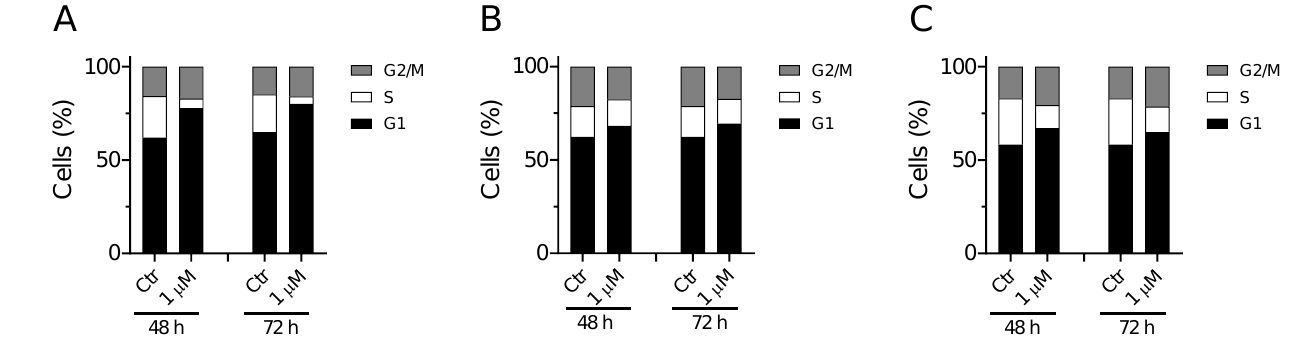
Figure 9. Effect of Ff-35 on cell cycle in A549 ( A ), Hela ( B ), and MDA-MB-231 cells ( C ). Cells were treated with the compounds for 48 and 72 h, at the concentration of 1.0 µM. After this period, the cells were processed as described in the Materials and Methods section.